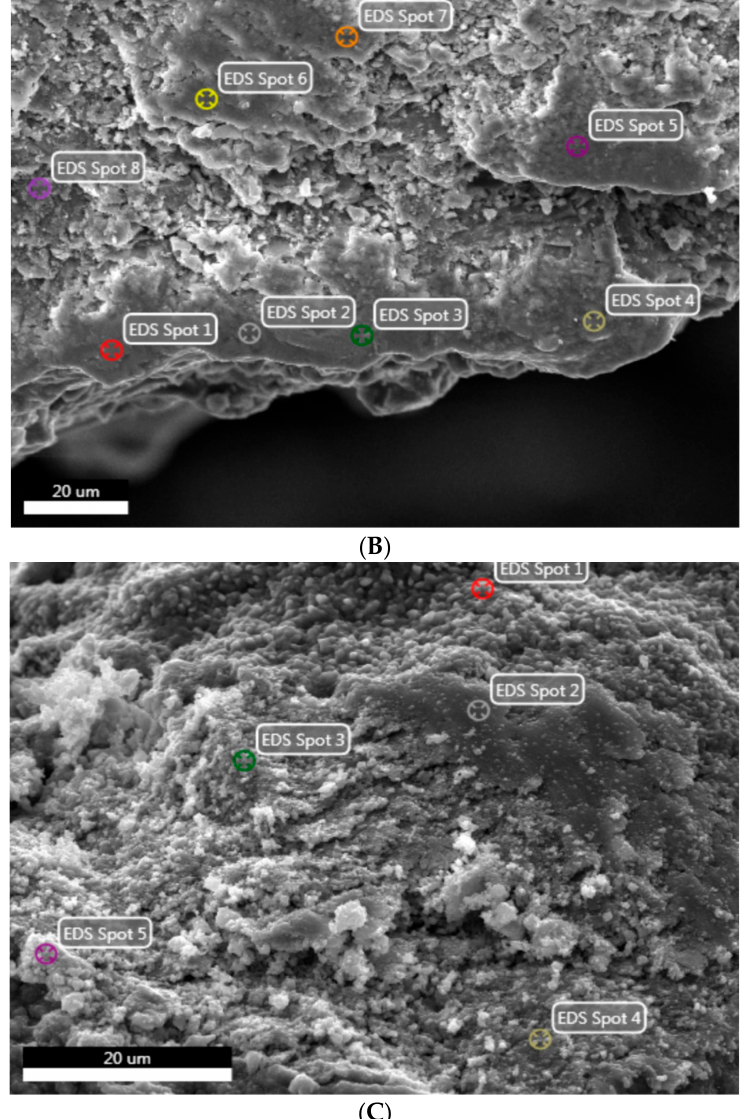
Figure 12. ( A ) Light aggregate pores filled with NaOH solution (magnification 2000×). ( B ) The surface of LWA in geopolymer matrix separated for EDS spots. ( C ) The EDS spots marked inside LWA.